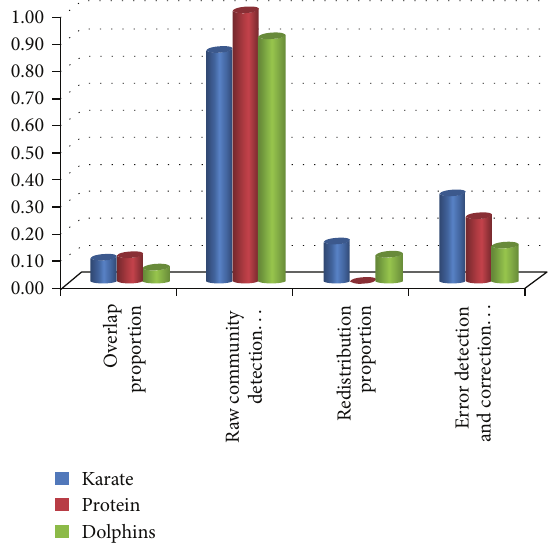
Figure 10: The proportion of the various types of nodes in